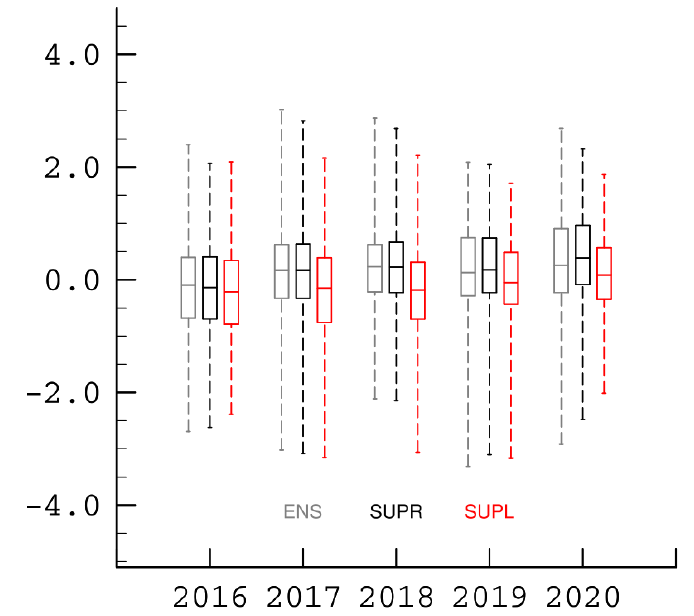
Figure 3. Box-and-whisker plot of mean bias errors (MBEs) derived from ensemble forecast of ENS (grey), SUPR (black), and SUPL (red) for 2016–2020. The bounds of the box at the 25th and 75th percentile and the flat line in the box is the median, and the whiskers represent the minimum and maximum values.